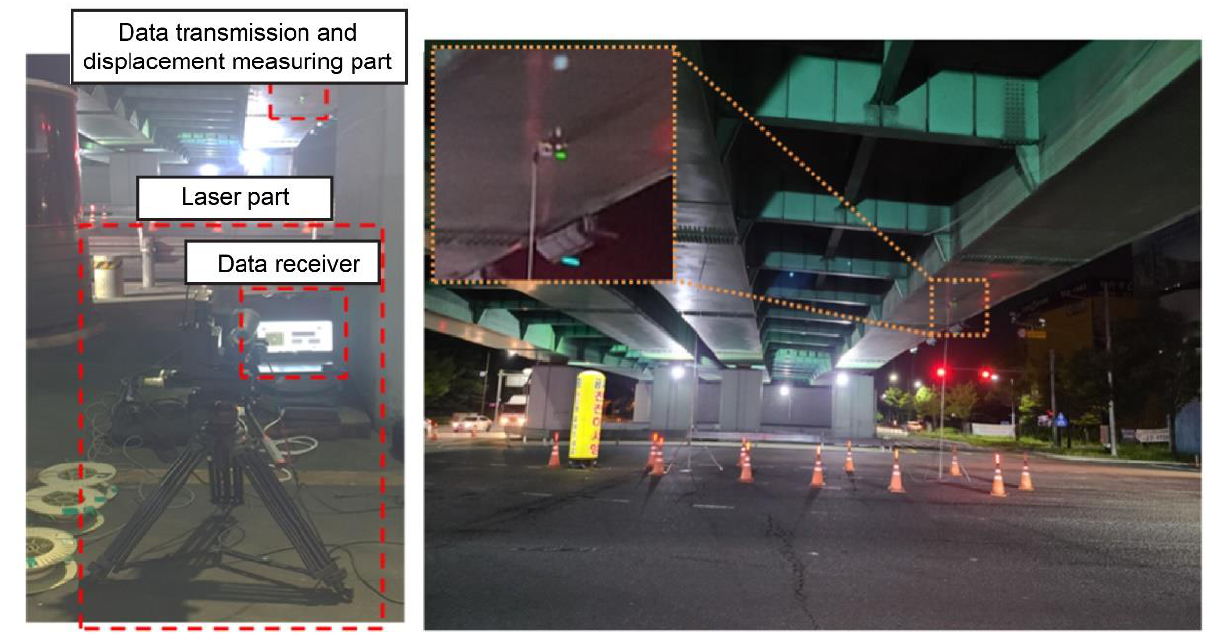
Figure 9. Experimental setup for the field test.